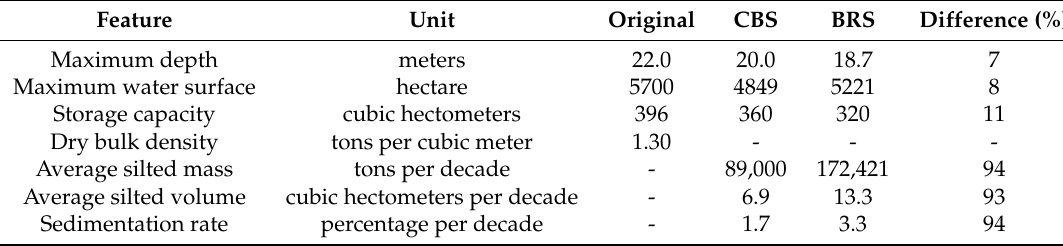
Figure 7. Water-level–volume ( a ); and water-level–area ( b ) curves of the Pentecoste reservoir (Project—original curves; CBS—Conventional bathymetric survey; BRS—Bathymetric survey using Remote Sensing simplified method). Table 3. Main features of the silted Pentecoste reservoir according to both methods: CBS (Conventional bathymetric survey) and BRS (Bathymetric survey using Remote Sensing simplified method). The difference refers to the methods (CBS vs.